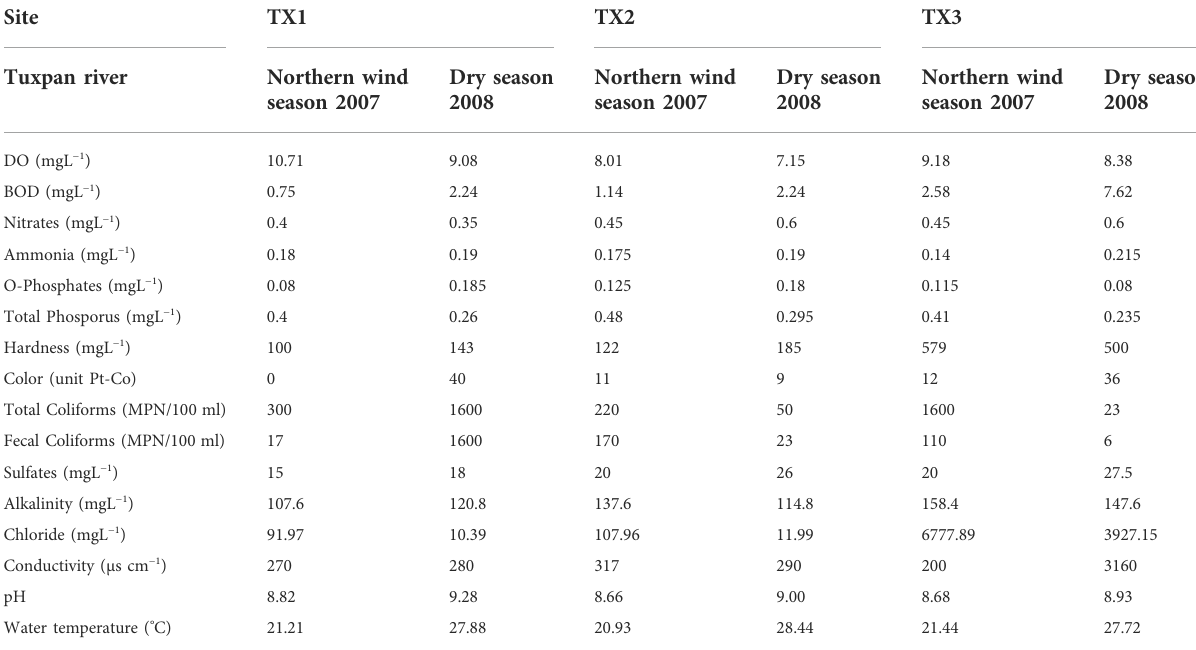
TABLE 2 Water quality features for Tuxpan